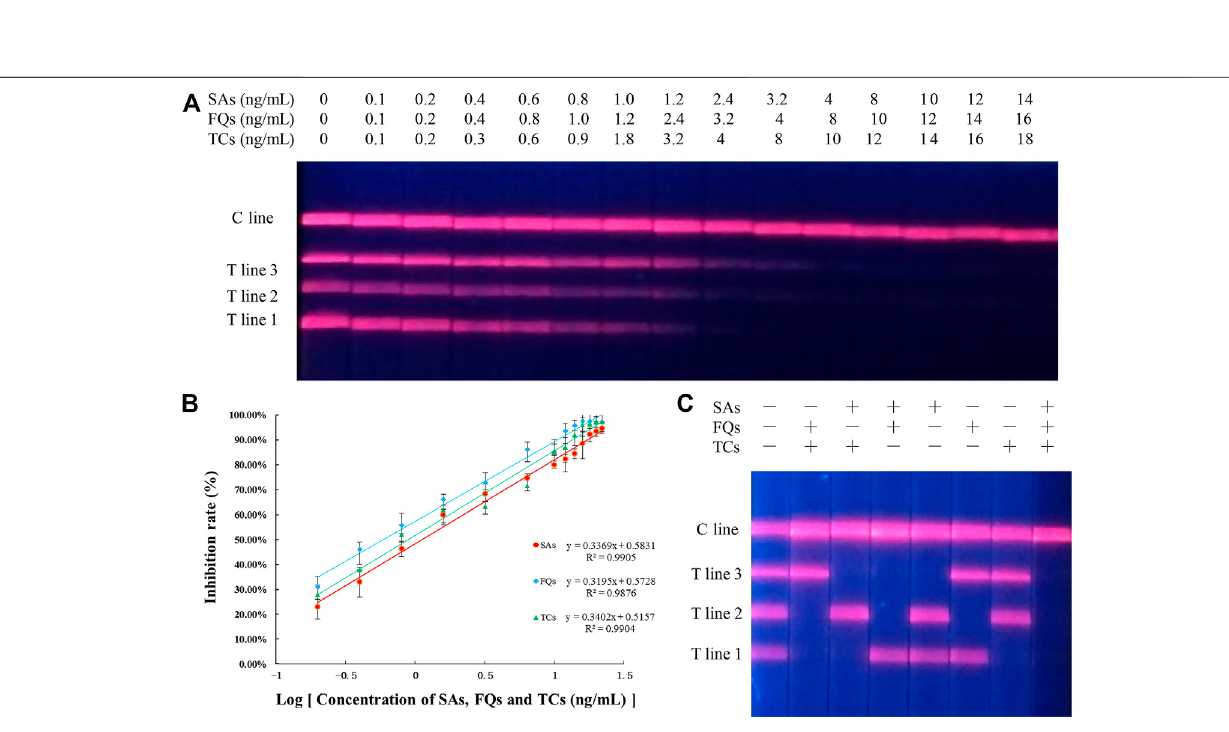
Frontiers in Chemistry |